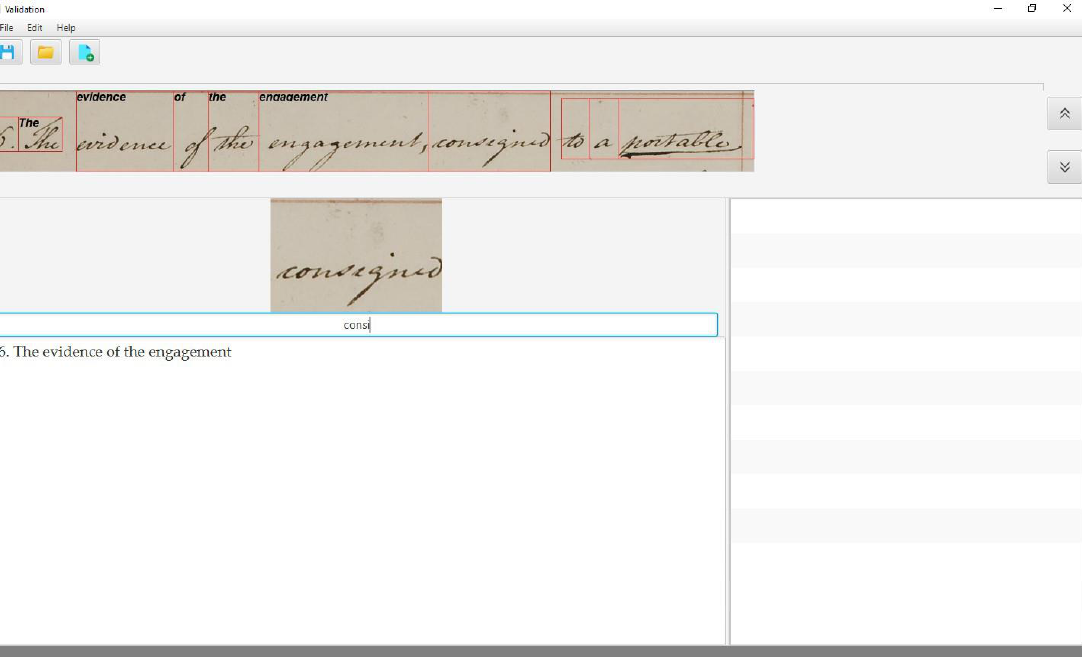
Figure 5. The word “ consigned ” is a correct out-of-vocabulary (OOV) word: the output list is empty and the user enters the entire transcription.